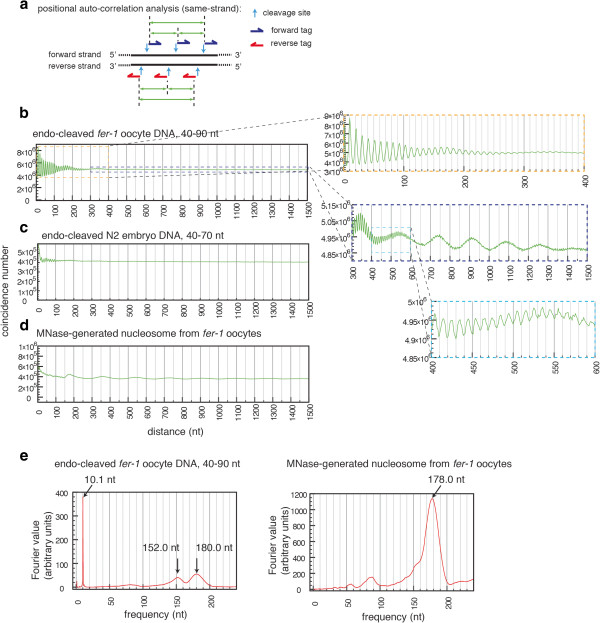
Autocorrelation analysis of DNA fragments from Caenorhabditis elegans fer-1(b232) oocytes and wild type (N2) embryos. (a) A schematic diagram showing an example of global positional correlation analysis. For each pair of tags that match to the same strand, the distance between the tags is recorded. (b-d) The coincidence of tag pairs is plotted as a function of the distance between two tags that match to the same strand for endo-cleavage DNA fragments (40 to 90 nt size range, single-end Illumina sequencing tags) from activated fer-1(b232) oocytes (b), 40 to 70 nt fragments from N2 embryo (c), or MNase-generated nucleosome core DNA from activated fer-1(b232) oocytes (d). (e) Fast Fourier transform analysis of coincidence over positional correlation analysis.